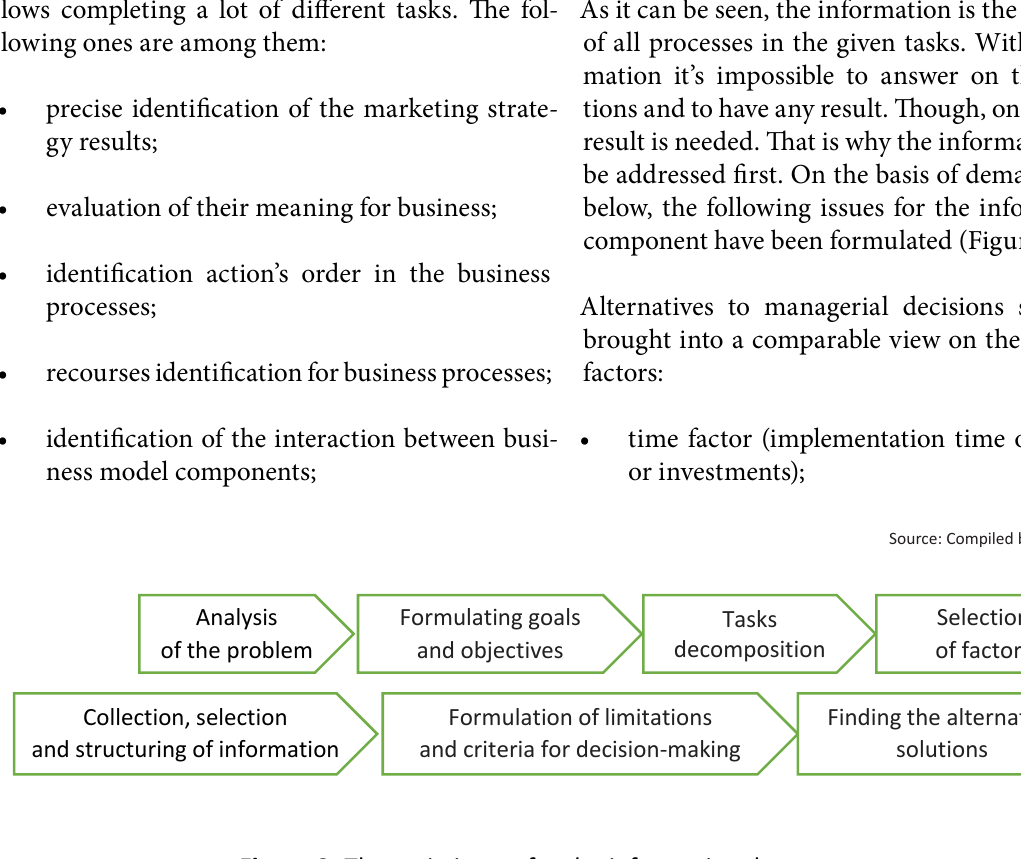
Figure 2. The main issues for the informational